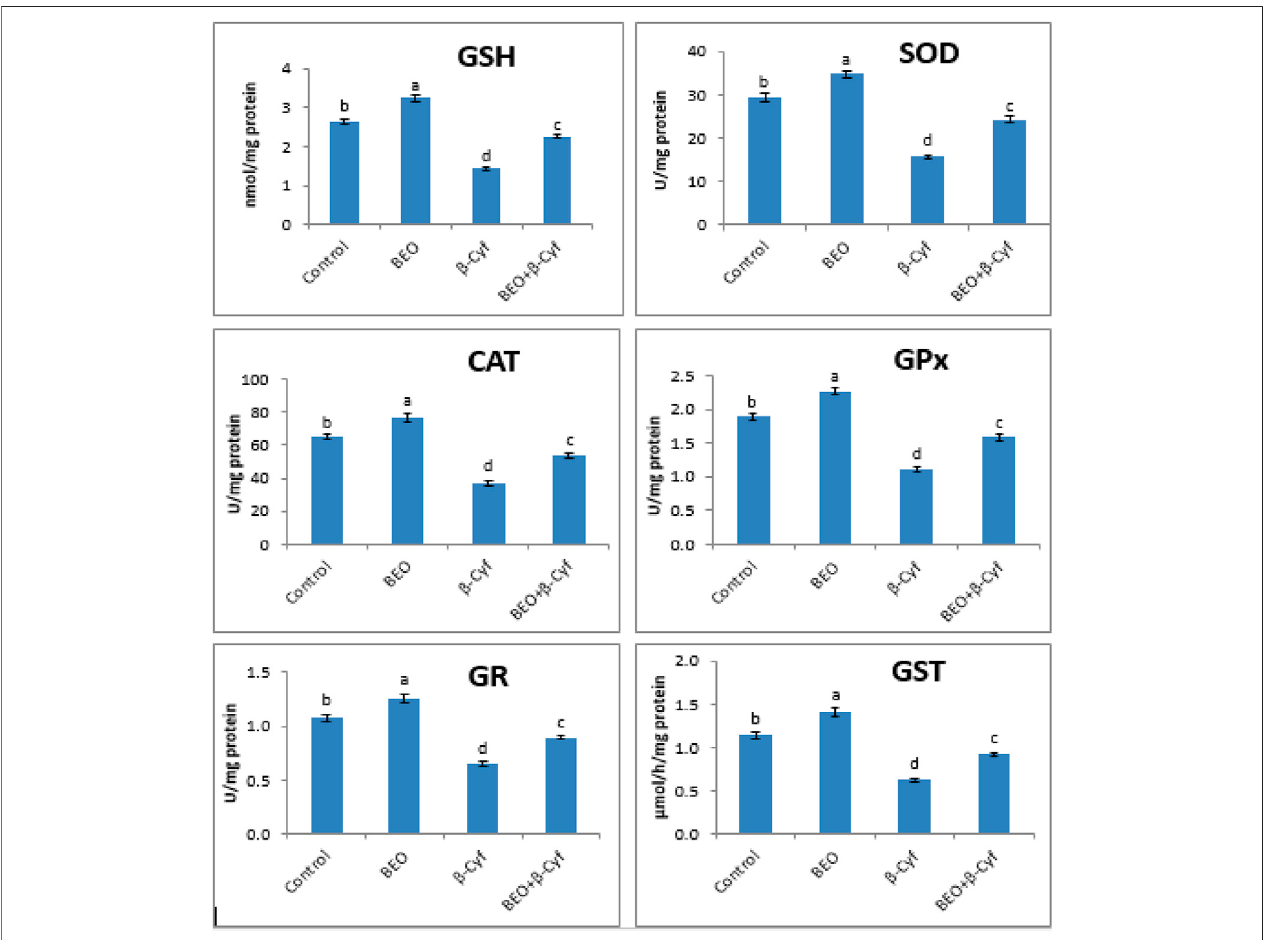
FIGURE3| Reducedglutathione(GSH)contentandactivitiesofsuperoxidedismutase(SOD),catalase(CAT),glutathioneperoxidase(GPx),glutathionereductase (GR), and glutathione S-transferase (GST) in the liver of male rats treated with BEO, β -Cyf, and BEO plus β – Cyf. Values are expressed as mean ± SE of seven rats per group.Columnswithdifferentlettersaresigni fi cantlydifferentat p < 0.05.Groupsarecomparedasfollows:BEOand β – Cyfgroupsarecomparedtothenegativecontrol group while BEO + β -Cyf group is compared to the positive control group, β -Cyf.